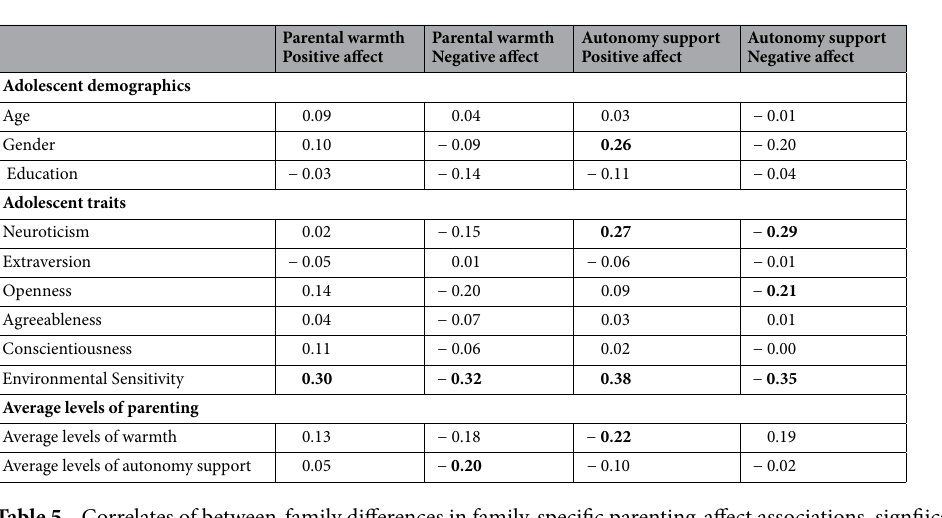
Table 5. Correlates of between-family differences in family-specific parenting-affect associations. signfiicant values are in bold (Credibility interval does not contain 0). Gender was coded 0 = male, 1 =